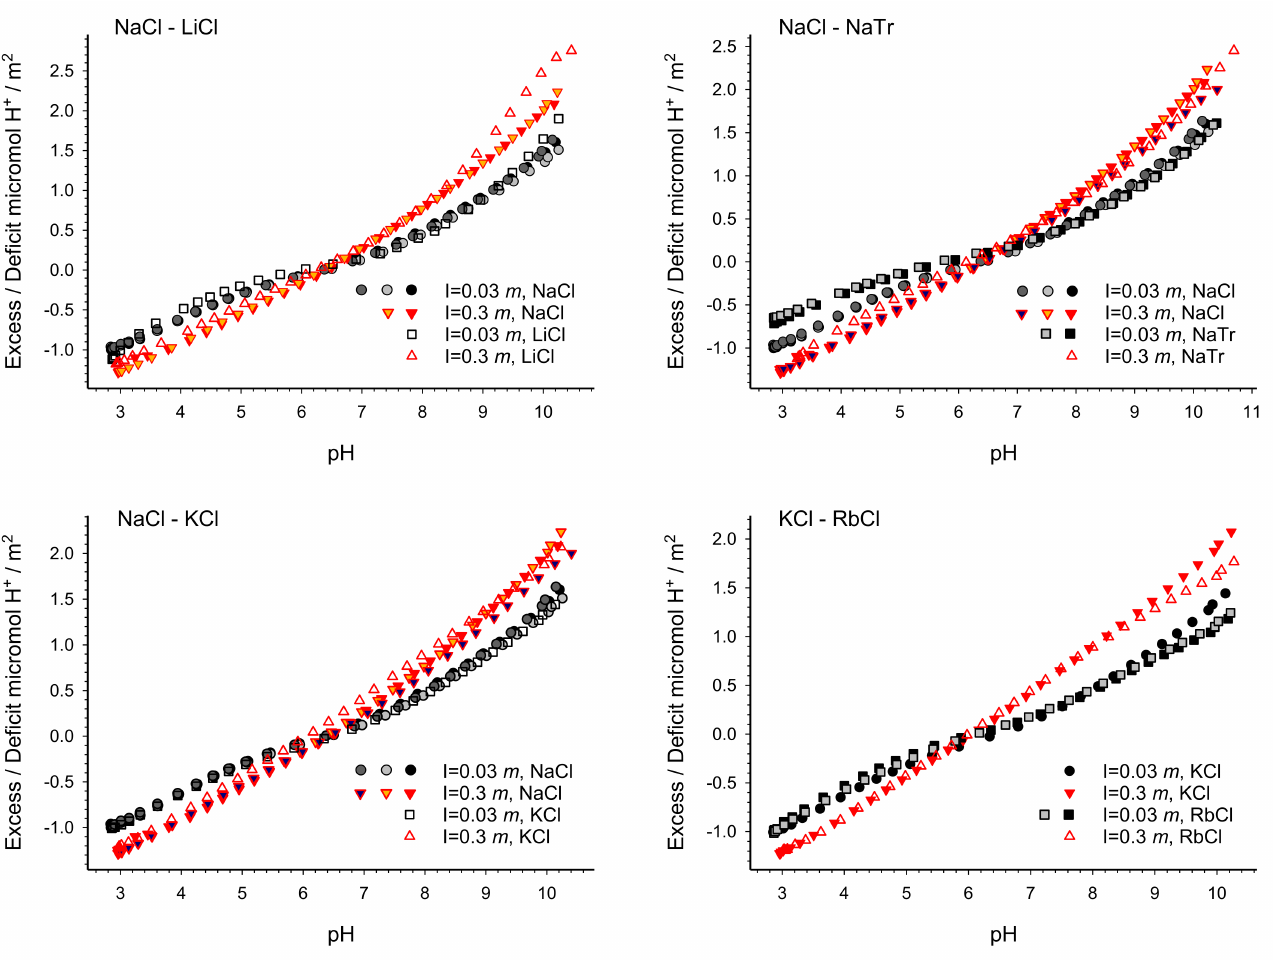
Figure 3. Relative proton adsorption or desorption on the 4 nm sized anatase sample showing the effect of electrolyte